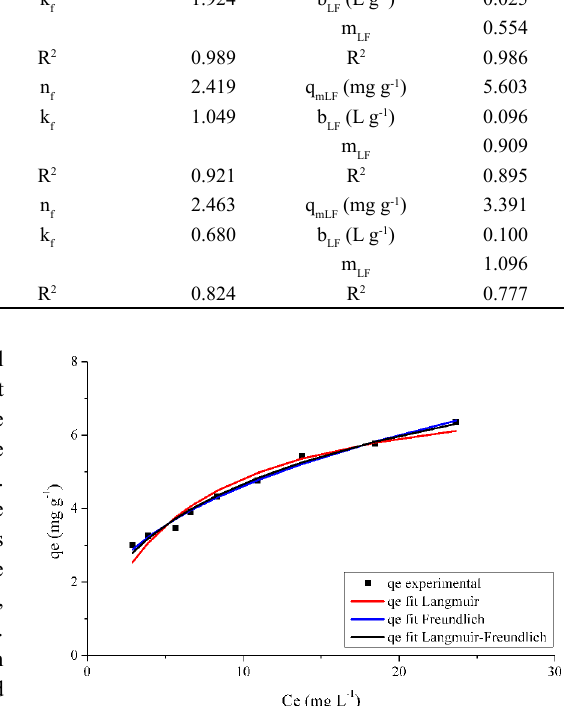
Figure 8. Experimental and predicted adsorption isotherms for tetracycline for the Langmuir, Freundlich and Langmuir-Freundlich models, at temperature of de 25°C.